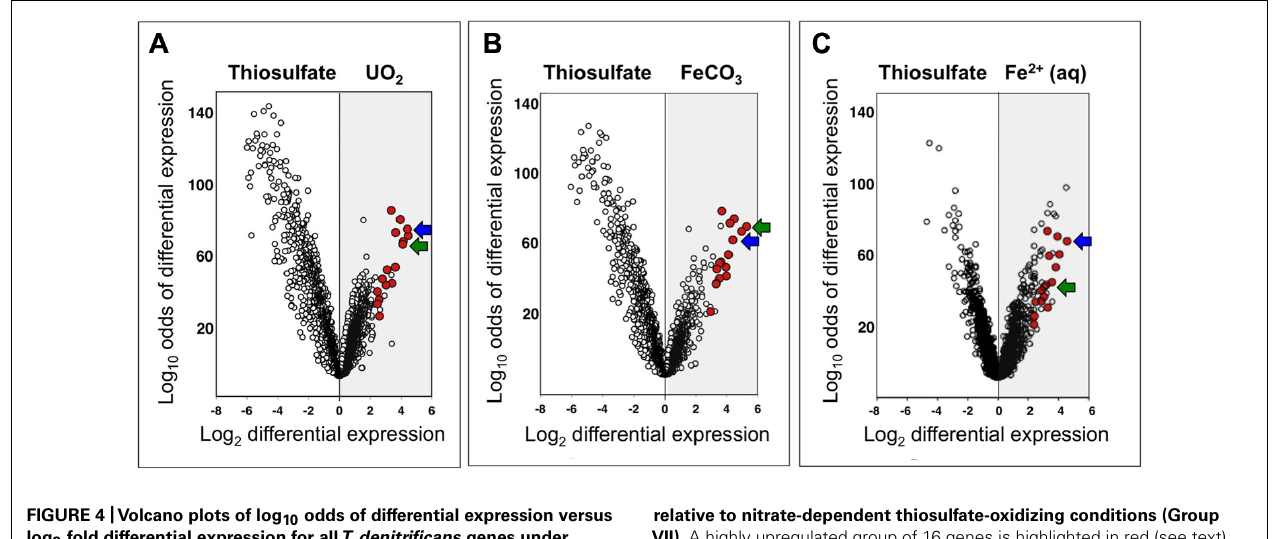
relative to nitrate-dependent thiosulfate-oxidizing conditions (Group VII). A highly upregulated group of 16 genes is highlighted in red (see text). Two of the most highly upregulated genes are indicated with blue arrows (Tbd_2628) and green arrows